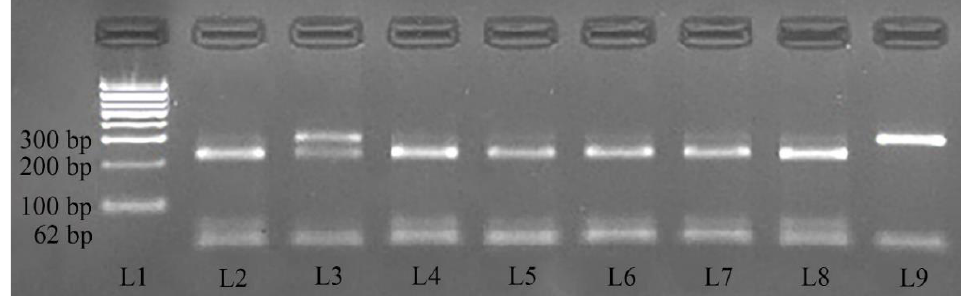
Figure 1. PCR-RFLP electrophoresis gel results highlighting the three genotypes. Legend: L1 corresponds to size standard (100-bp DNA ladder); samples L2, L4, L5, L6, L7, and L8 correspond to genotype G/G (230 bp and 62 bp); sample L3 corresponds to genotype A/G (292 bp, 230 bp, and 62 bp); sample L9 corresponds to genotype AA (292 bp).